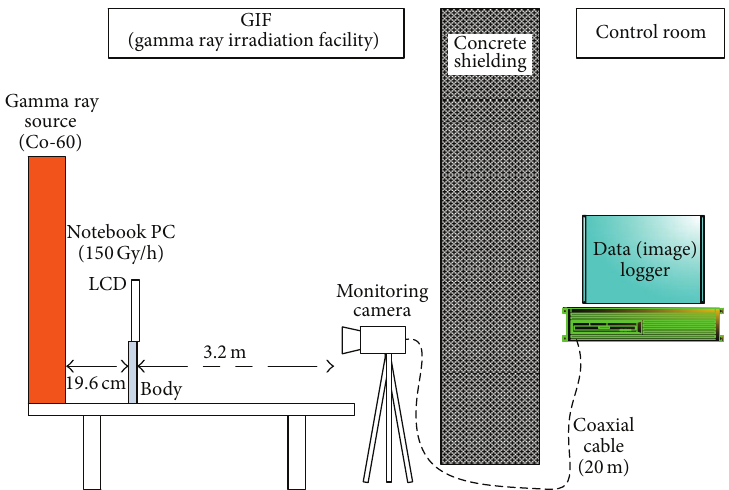
Figure 2: Schematic diagram for gamma ray irradiation test of the notebook